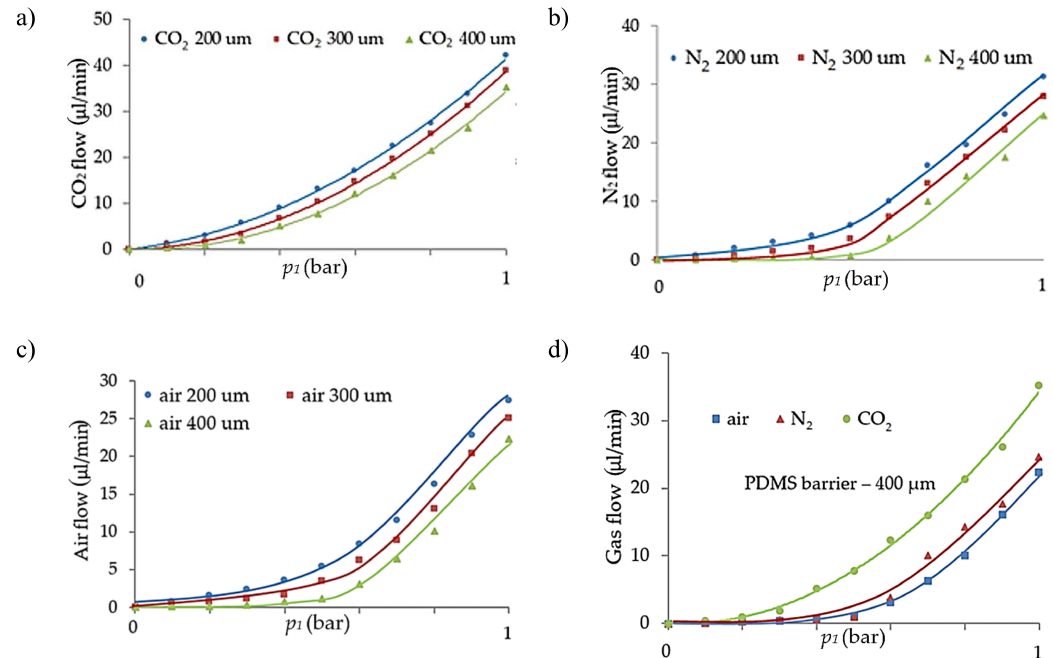
Figure 5. Gas flow characteristics of the regulator for different polydimethylosiloxane (PDMS) membrane thicknesses: ( a ) CO 2 flow; ( b ) N 2 flow; ( c ) air flow; ( d ) flow comparison for the selected gases with a 400 µ m thick PDMS membrane.